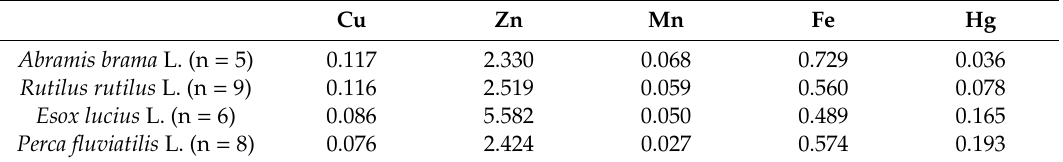
Table 4. Estimated daily intake EDI ( µ g / kg body weight / day).